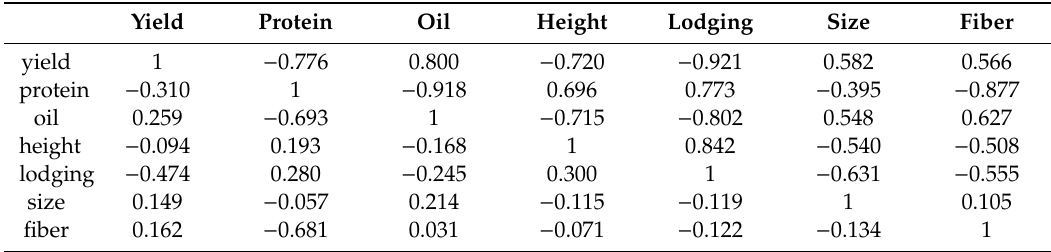
Table 3. Phenotypic (lower diagonal) and genetic (upper diagonal) correlation among 7 traits from the Nested Association Mapping (SoyNAM) project comprising information on 2560 genotypes belonging to 40 bi-parental families tested in Nebraska in 2012.